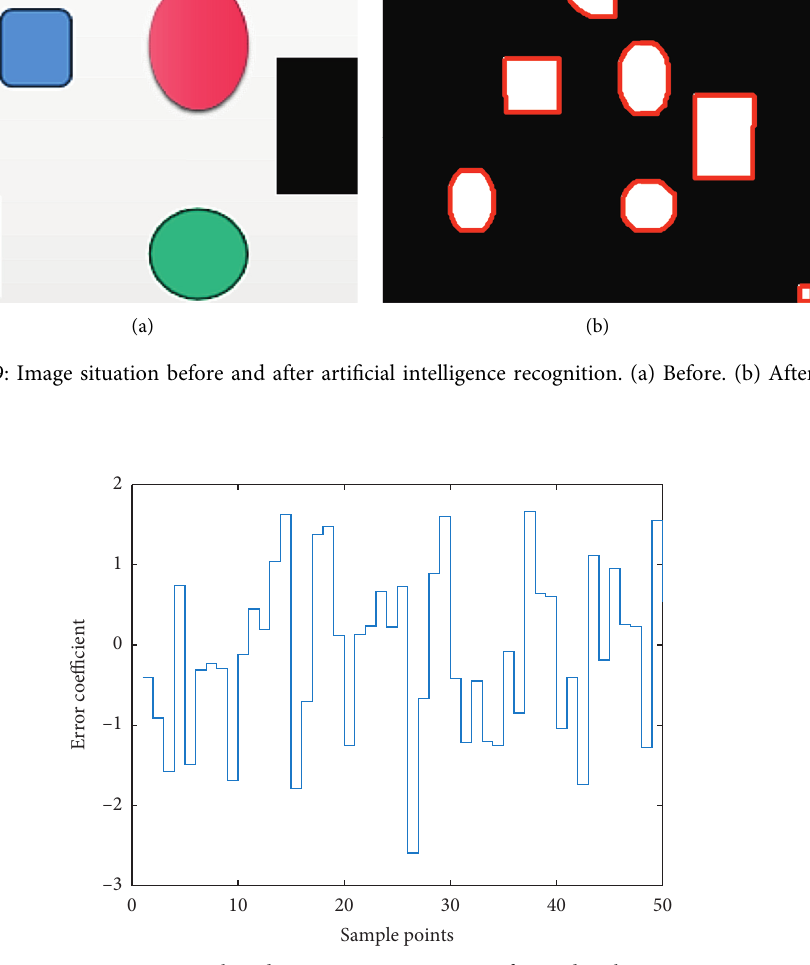
Figure 10: Distributed image recognition error factor distribution.